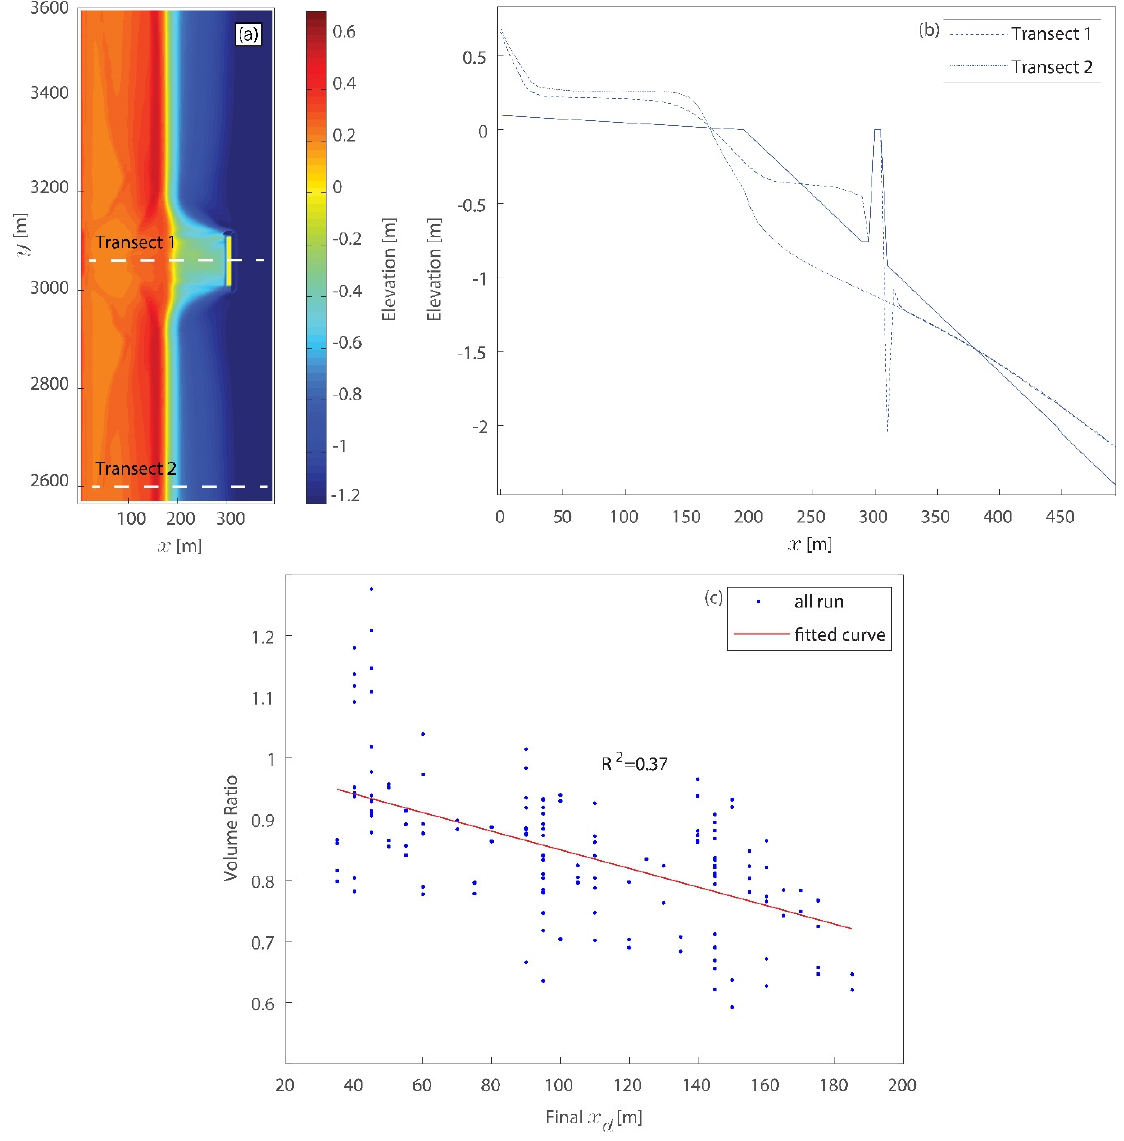
Figure 10. ( a ) The 2D bed level at the end of the simulation with slope = 0.8% case, H s = 0.5 m, x d = 100 m and Tide = ± 0.4 m. ( b ) Longitudinal profile of transect 1 and 2 for the same simulation. The continuous line represents the initial condition, the dash line the transect 1 final bed level condition and the point line transect 2 final bed level condition. ( c ) Ratio between the deposited volume on transect 1 and 2 for all runs.